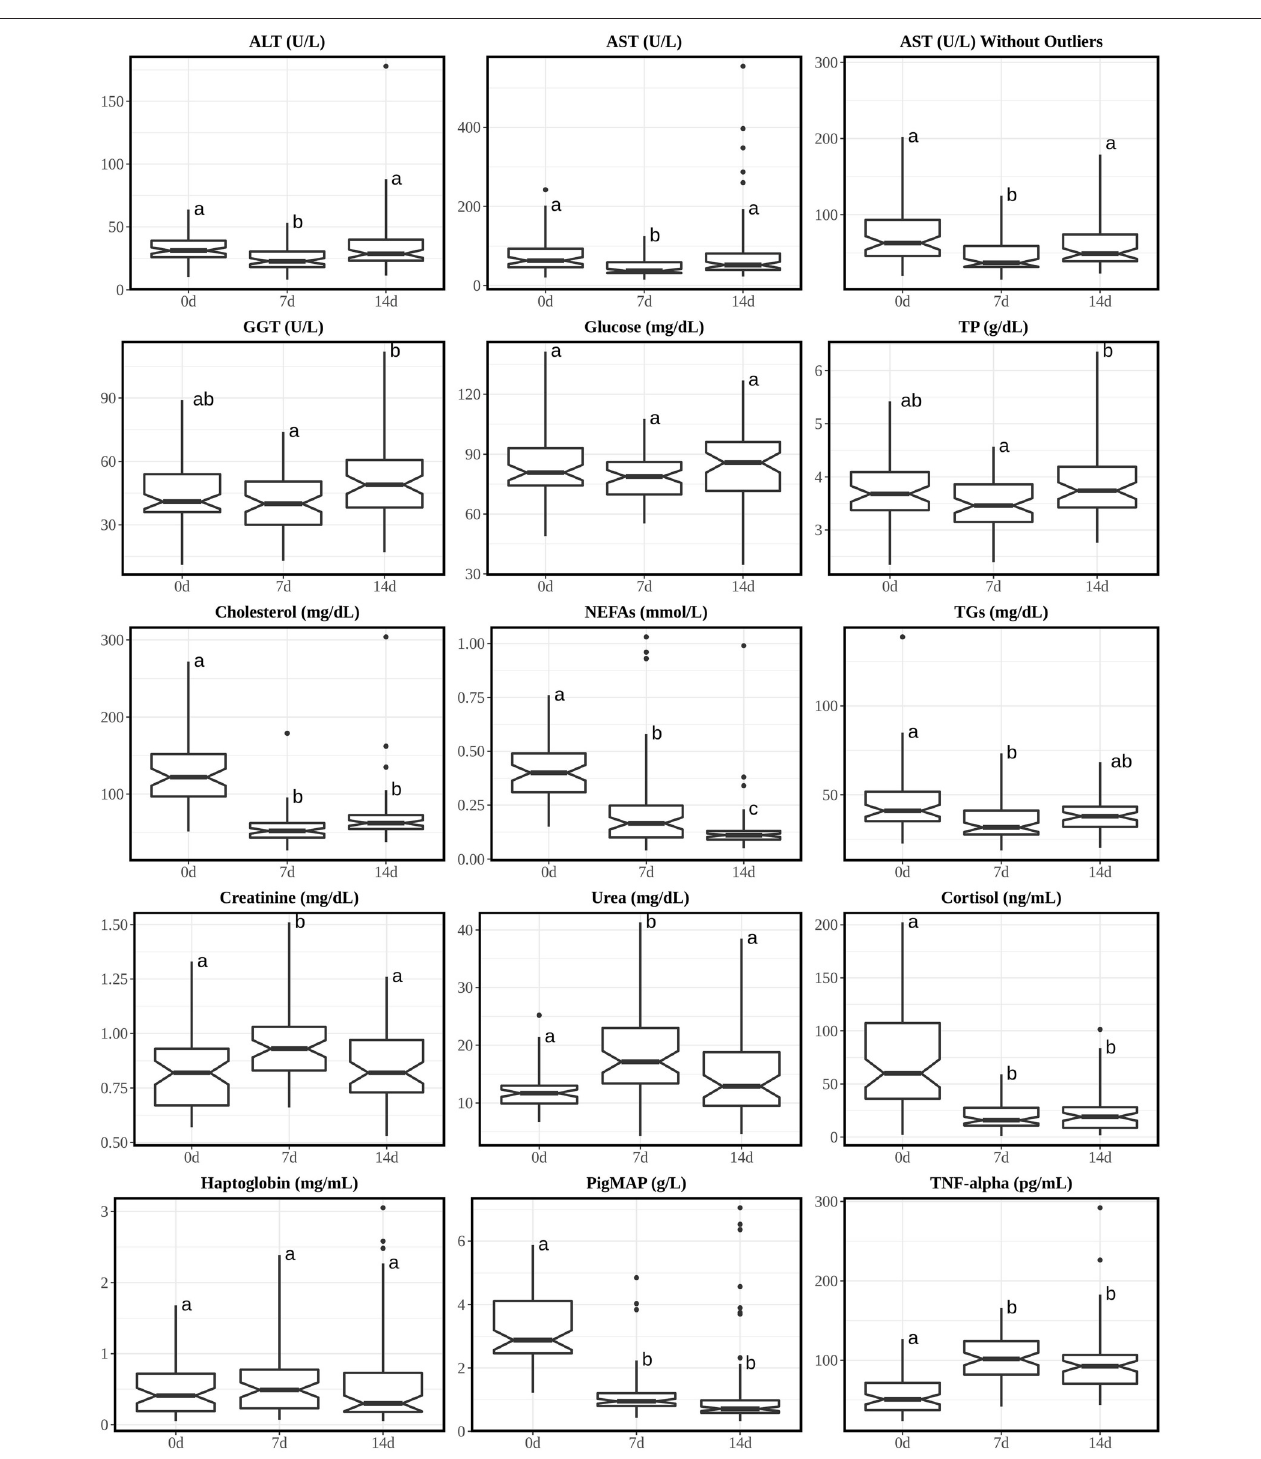
FIGURE 2 | Boxplots of analytes with Tukey’s HSD posthoc with Bonferroni correction from piglets’ sera at 0, 7, and 14 days post-weaning (age: 21, 28, and 35 days, respectively). Annotations over the boxes with different superscripts are significantly different ( p < 0.05). Interquartile fence was set between Q1-3*IQR and Q3 + 3*IQR. 0d, piglets at the 0 day of weaning (right after weaning); 7d, piglets at the 7th day of weaning; 14d, piglets at the 14th day of weaning. Analytes were alphabetically plotted according to the orders of